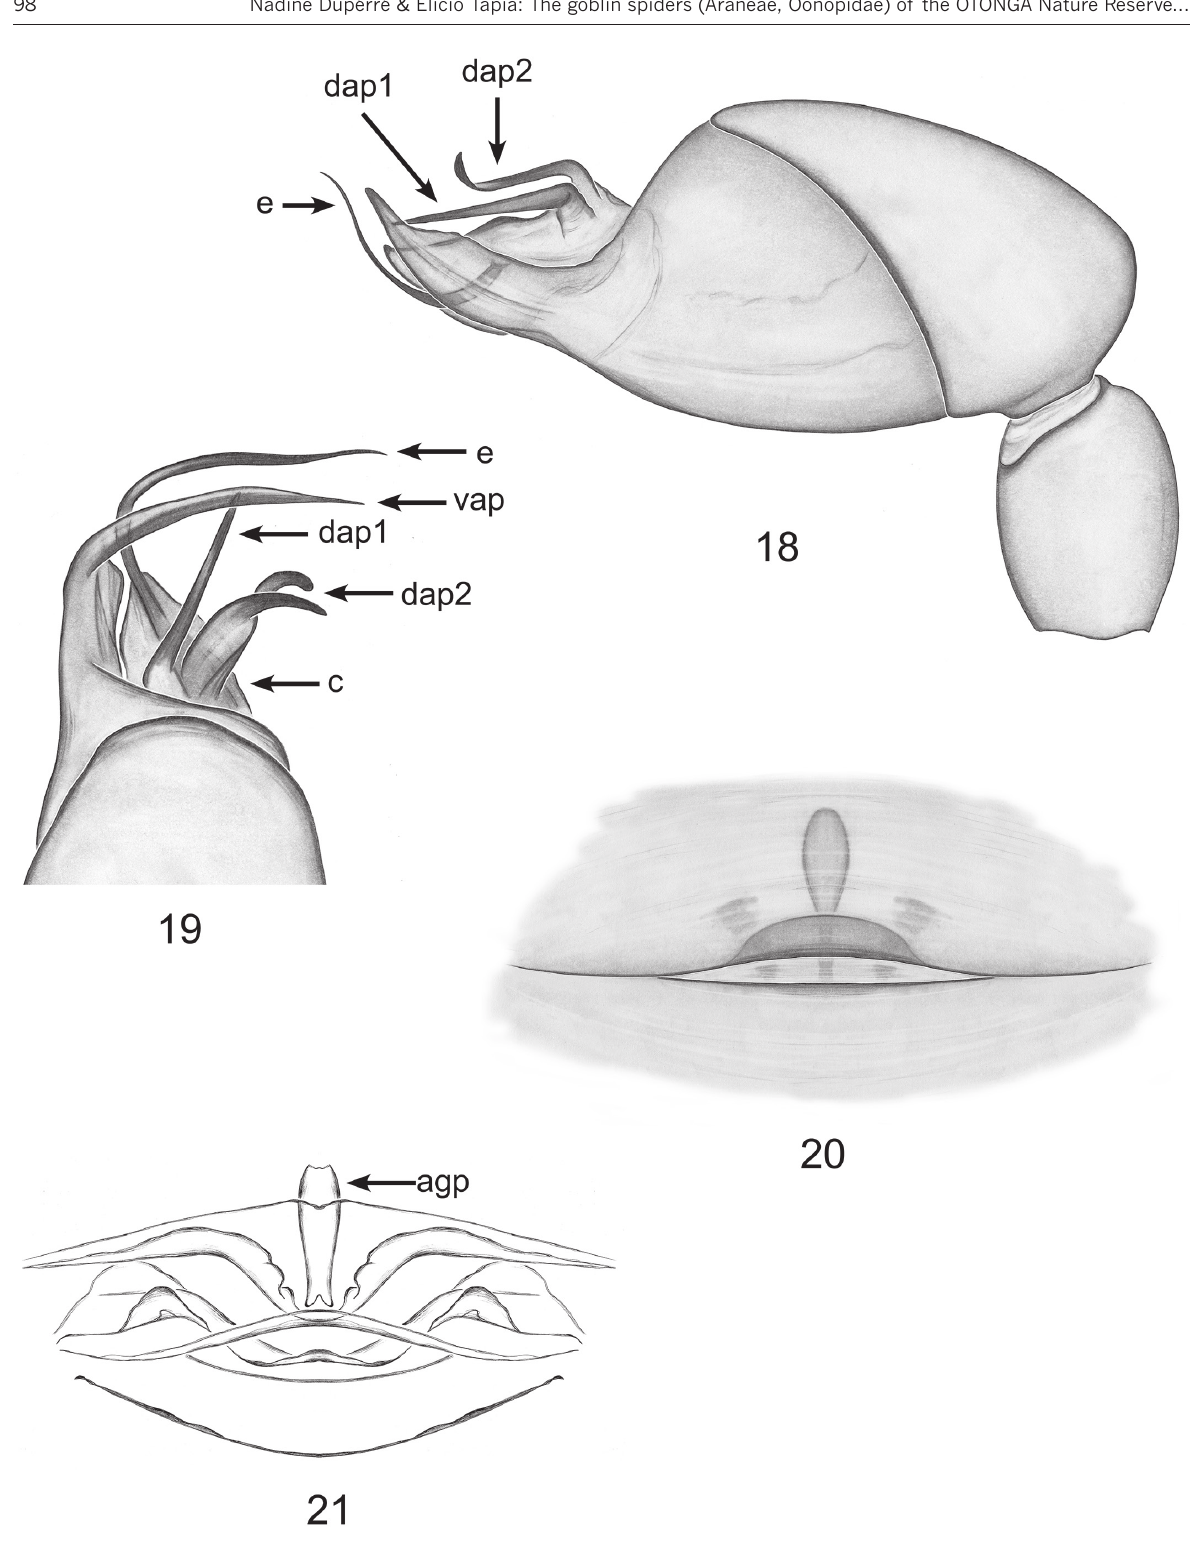
view, sloping forward in lateral view. Sternum longer than wide, surface smooth, radial furrows between coxae I–II, II–III, III–IV smooth, with an additional radial between en- dites and coxae I. Chelicerae straight, cheliceral teeth not